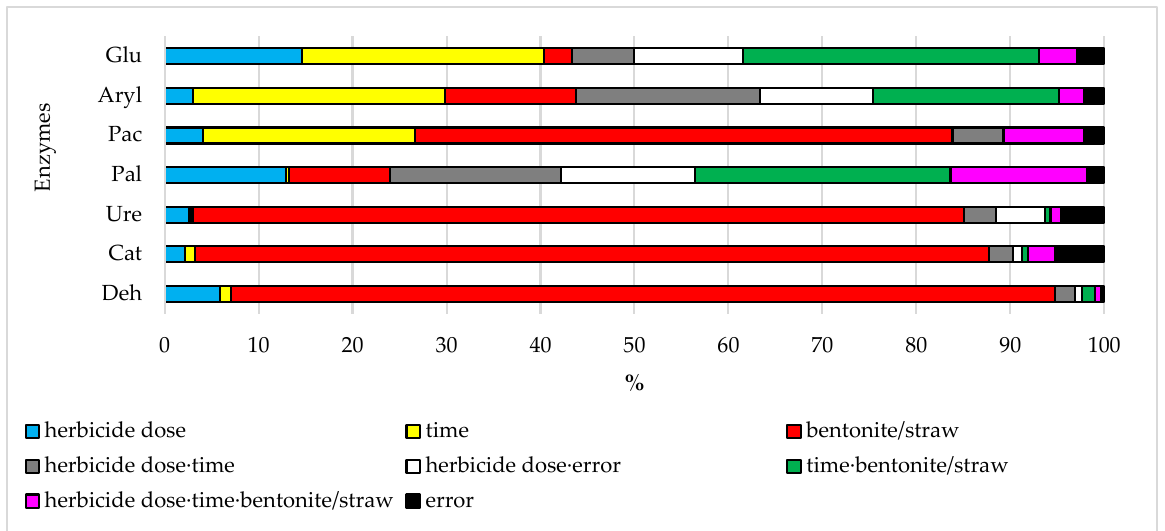
Figure 5. Percent of the observed variability enzymes η 2 in soil contaminated with Successor T 550 SE. Glu— β -glucosidase; Aryl—arylsulfatase; Pac—acid phosphatase; Pal—alkaline phosphatase; Ure—urease; Cat—catalase; Deh—dehydrogen- ases.